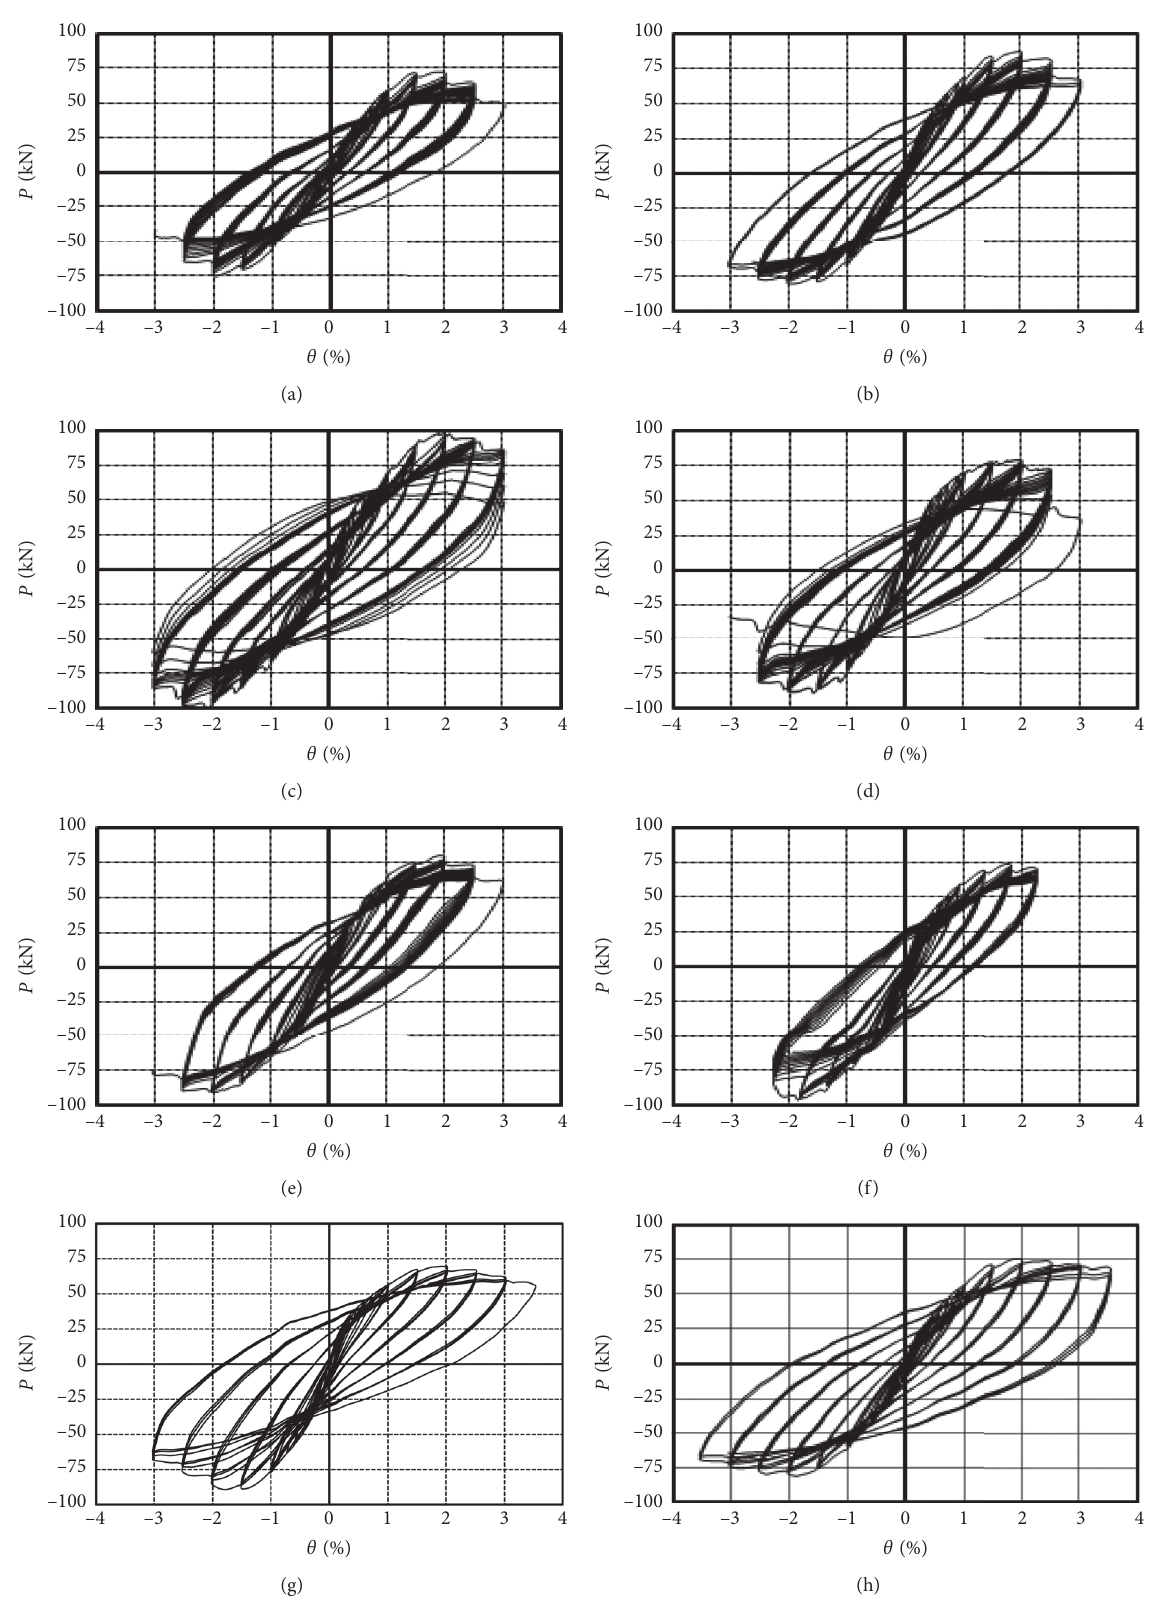
Figure 4: Hysteresis curves of horizontal load and displacement angle ( P − θ ) of specimens. (a) SRC1. (b) SRC2. (c) SRC3. (d) SRC4. (e) SRC5. (f) SRC6. (g) SRC1-2. (h)